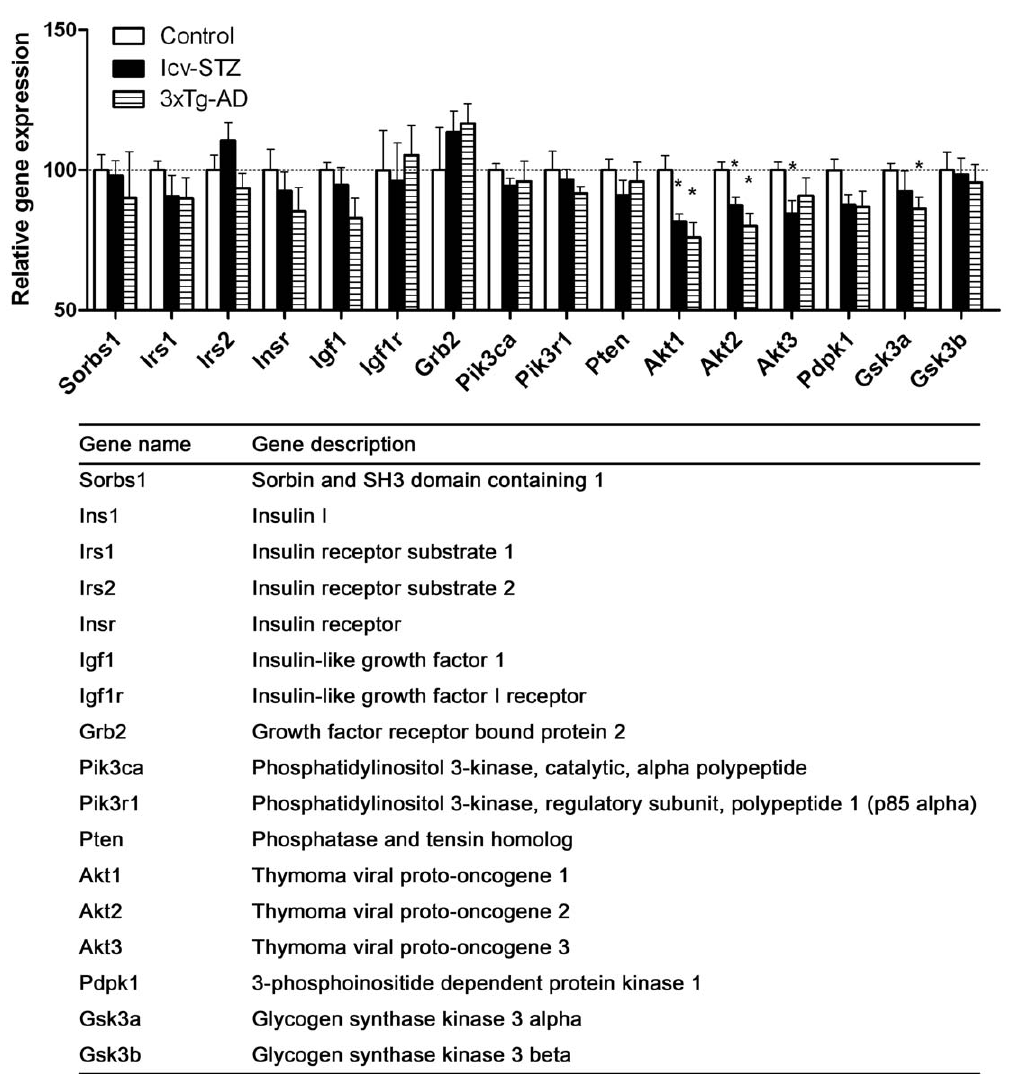
Figure 8. Insulin signaling–related gene expressions in the hippocampus.